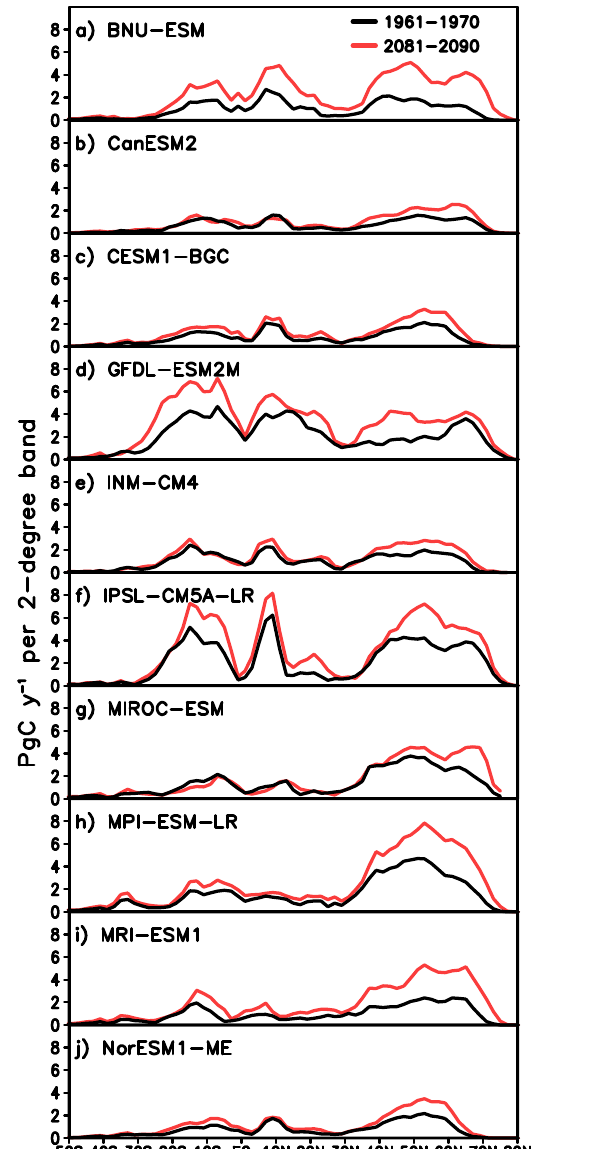
Figure 5. Zonal amplitude of NBP from the 10 CMIP5 mod- els (PgCmonth − 1 per 2-degree band), averaged over 1961–1970 (black) and 2081–2090 (red). For each model, NBP is first regridded to a 2 × 2 ◦ common grid. Monthly zonal totals are then computed for every 2-degree band, which determine the amplitude (maxi- mum minus minimum) at every band. The Southern Hemisphere has an opposite phase from its northern counterpart, but its magni- tude is small due to its small land area. The two subtropical maxima around 10 ◦ N and 10–15 ◦ S reflect the wet–dry seasonal shift in the Intertropical Convergence Zone (ITCZ) and monsoon movement. They have similar magnitude as the Northern Hemisphere maxima in about a third of the models, however their net contribution to global total NBP seasonal amplitude is small, because they are out of phase and largely cancel each other